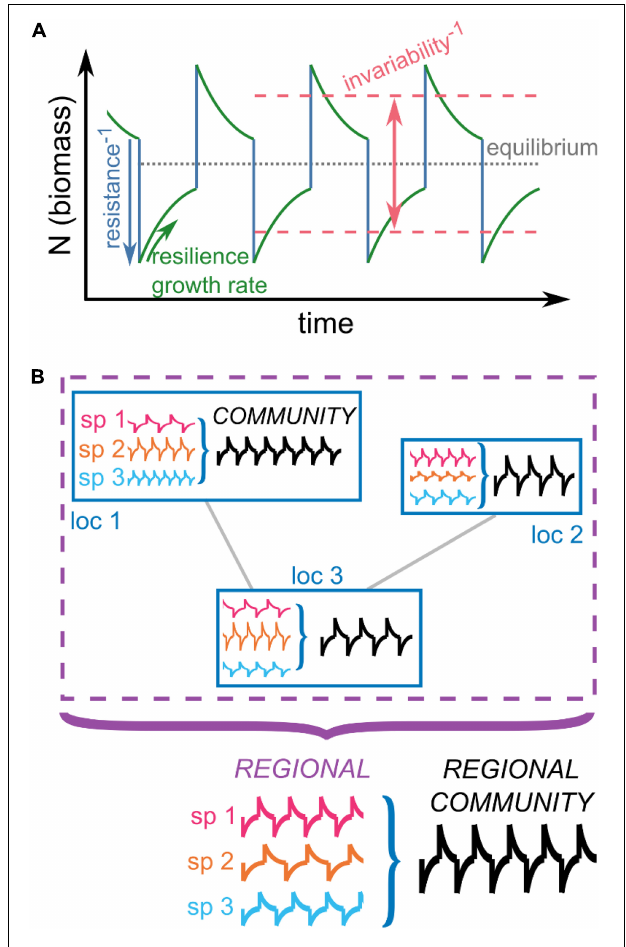
FIGURE 1 | (A) Different stability components considered throughout the manuscript. In solid lines, we represent the hypothetical dynamics of the biomass of one species affected by multiple periodic disturbances. Resistance (blue lines) is defined as the inverse of the change of biomass as a consequence of the direct effect of the disturbance. The growth rate and the initial resilience of the system (green lines) both quantify the rate at which the system tends to recover to the equilibrium after the effect of the disturbance. The main difference between growth rate and initial resilience is whether it is computed relatively to the biomass prior the disturbance (growth rate), or relatively to the distance between the biomass after the perturbation and the equilibrium biomass (initial resilience). In both cases, we will consider the short-term response, in contrast to the asymptotic resilience (not considered in this manuscript). Finally, invariability (red dashed lines) represents the ability of the systems to remain close to the equilibrium when multiple disturbances affect (periodically or randomly) the species. Panel inspired by Clark et al. (2021). (B) In meta-communities, multiple species (“sp”) form communities located at multiple locations (“loc”) forming a region. We define the regional stability as the stability of the total biomass of one species across locations, and community stability as the stability of the total biomass across species in one